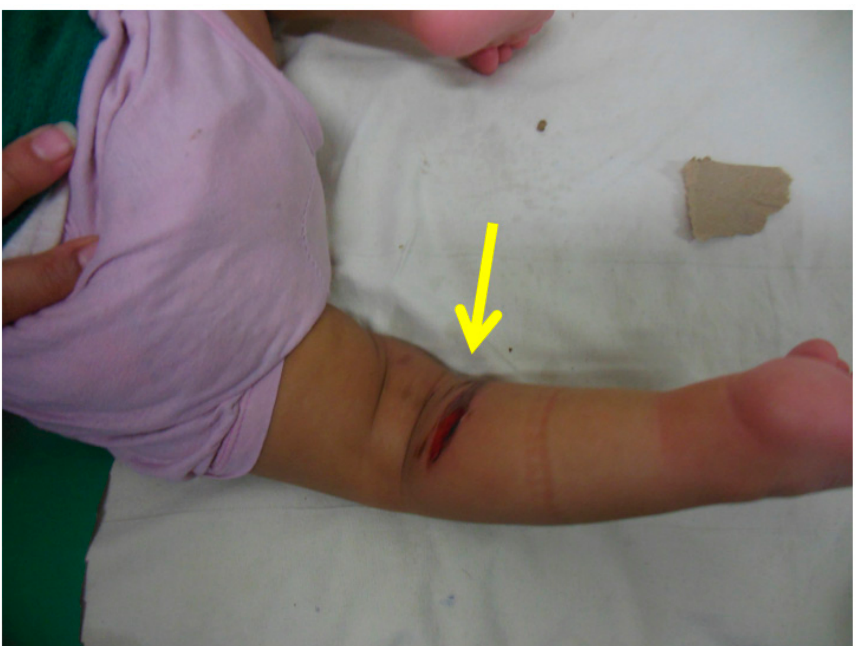
Figure 4. Clinical photograph showing a pressure sore over the medial side of the foot (pointed by the arrow) due to inadequate padding.